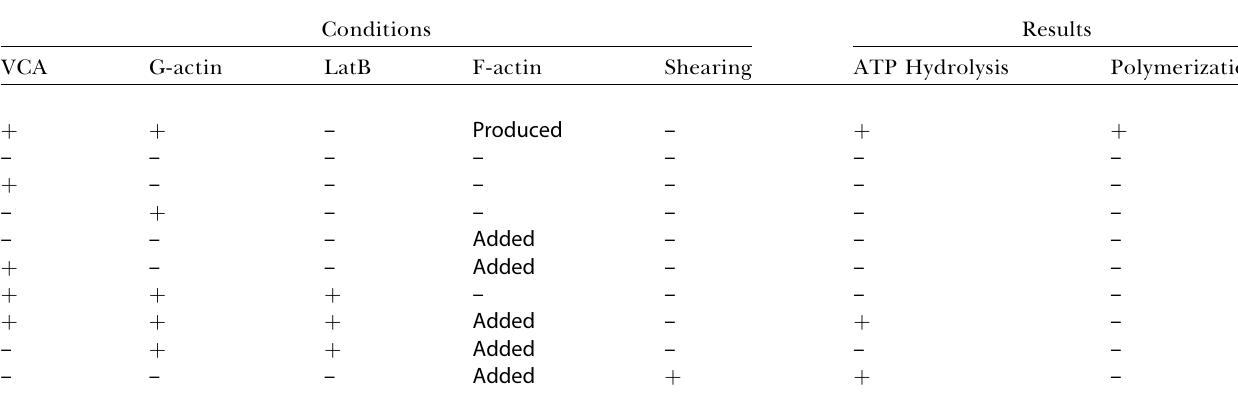
Table 1. Requirements to Stimulate ATP Hydrolysis on the Arp2 Subunit of Arp2/3